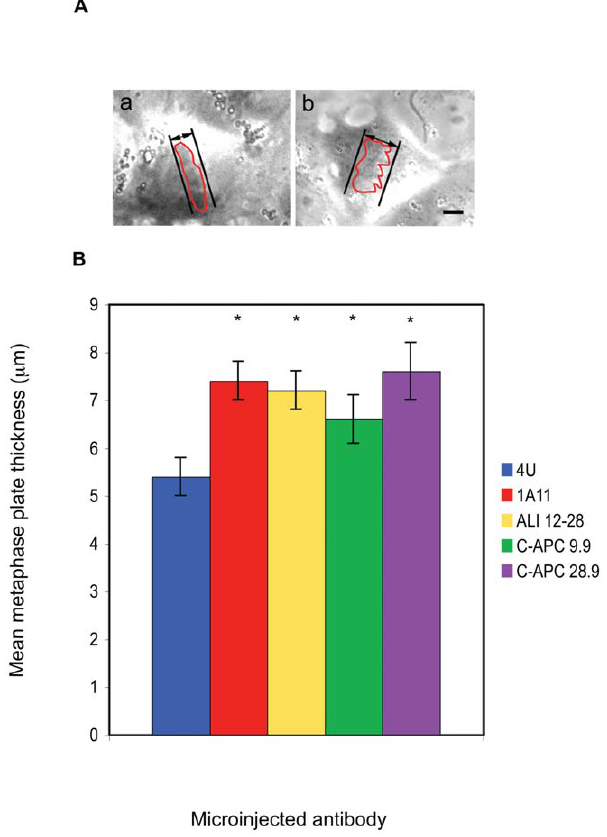
Figure 4. Microinjection with EB1 or APC specific antibodies affects chromosomal congression at the metaphase plate. A: Movies of microinjected cells were examined and the last frame before anaphase onset identified. The distance separating the widest two points of the metaphase plate was then measured as indicated. In the representative examples shown it can be seen that the metaphase plate was more tightly compacted in cells injected with control IgG (panel a) than in cells microinjected with 1A11 (panel b). Scale bar=5 m M. The red traces indicate the outline of the metaphase plates. B: Summary of the metaphase plate thickness data. The metaphase plate was significantly wider in cells microinjected with APC or EB1 specific antibodies when compared to cells injected with the non-specific antibody 4 U. Mean distances + / 2 SEM are shown. Significant results are shown with an asterisk. P values were for 1A11, p , 0.005; ALI 12–28, p , 0.005; C-APC 9.9, p , 0.05 and C-APC 28, p , 0.005. (4 U, n=11; 1A11, n=14; ALI 12–28, n=11, C-APC 9.9, n=12; C-APC 28.9,